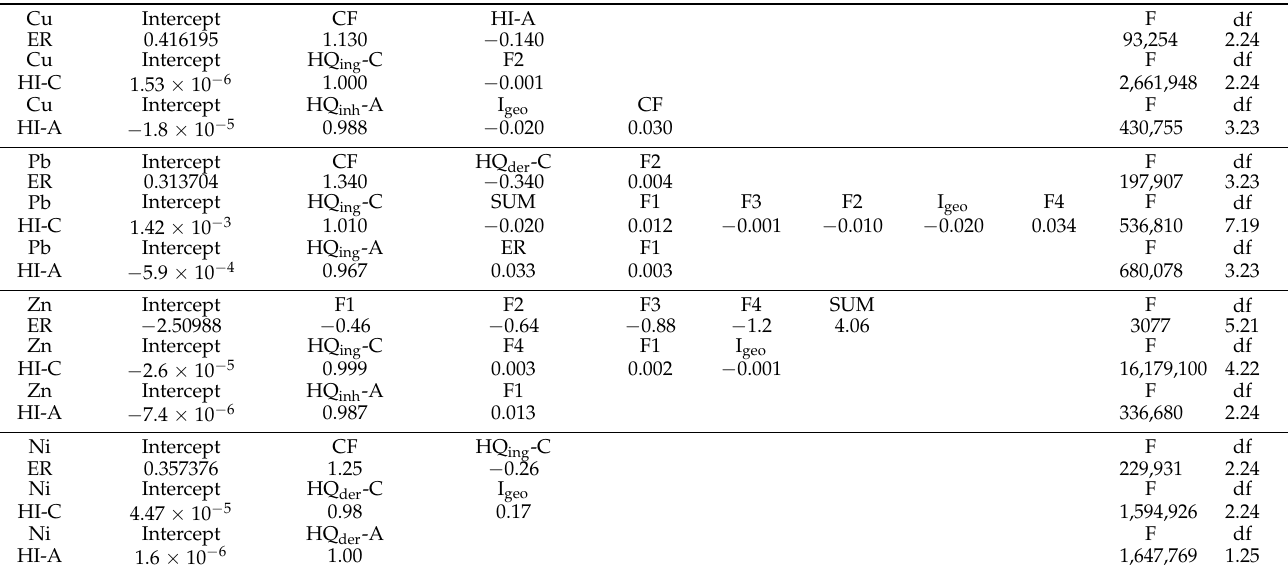
Figure 3. Clustering patterns of the nine sampling sites of Cu, Ni, Pb and Zn in the sediments based on I geo , CF, and ER, and the geochemical fractions of the sediments (F1, F2, F3, F4 and SUM). All values have been log 10 (value+1) before cluster analysis; Sampling sites’ information followed those in Table S1. The outputs of the multiple stepwise regression analytical outputs, based on ER as a dependent variable and independent variables, are the hazard quotient pathways and ge- ochemical fractions of the sediments, and are presented in Table 3. CF and HI-A were selected as the influential factors for the Cu ER. Three variables (CF, HQ der -C and F2) were selected as the influential factors for the Pb ER. Five variables (F1, F2, F3, F4 and SUM) were selected as the influential factors for the Zn ER. CF and HQ ing -C were selected as the influential factors for the Ni ER (Table 3). Table 3. Multiple stepwise regression analytical outputs based on hazard index (HI) and ecological risk (ER) as dependent variables and independent variables are the hazard quotient pathways and geochemical fractions of the sediments.